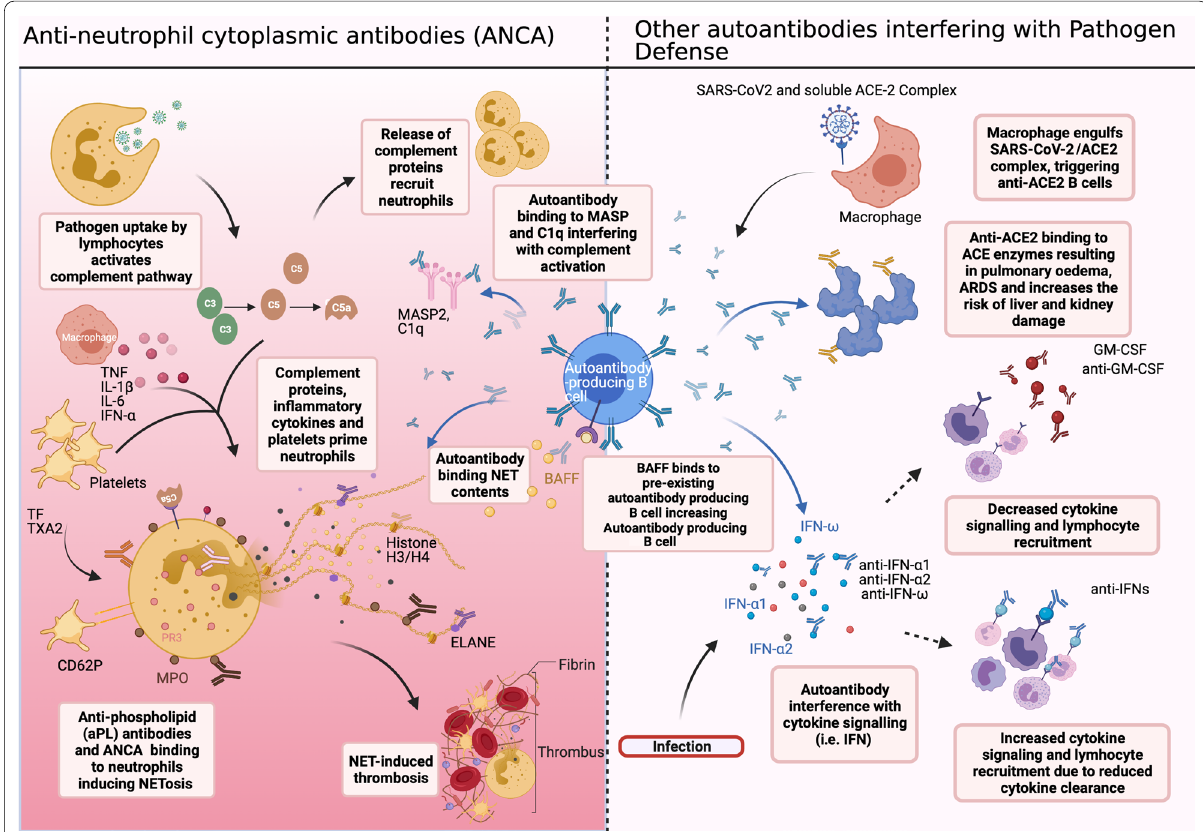
Fig. 1 Potential processes affected by presence of autoantibodies in COVID-19. Left panel: pathogen uptake results in release of inflammatory markers and complement proteins which lead to neutrophil recruitment, activation and translocation of autoantigens. Anti-neutrophil cytoplasmic antibodies (ANCA) (anti-MPO, anti-PR3, anti-ELANE, and anti-aPL autoantibodies and anti-H3/H4), bind autoantigens and promote NETosis which induces a thrombotic response. NET contents can be recognised by anti-MPO, anti-H3/H4 and anti-ELANE autoantibodies. Autoantibodies to complement proteins (anti-MASP2, anti-C1q) interfere with complement activation. Right panel: autoantibodies bind to the B cell activating factor (BAFF) which enables production of more autoantibodies by pre-existing autoantibody producing B cells. Autoantibodies which interfere with pathogen defence include antibodies to complement, tissue antigens and cytokines which can disrupt cytokine communication (anti-GM-CSF) and cytokine clearance (anti-IFNs). SARS-CoV-2 bound to soluble ACE2 complex can be phagocytosed by macrophages and presented on the surface, inducing anti-ACE2 antibodies. Anti-ACE2 can bind soluble ACE2, reducing its capacity to act as a decoy for SARS-CoV-2, as well as have cross-reactivity with surface attached ACE, triggering further detrimental inflammation. Created with